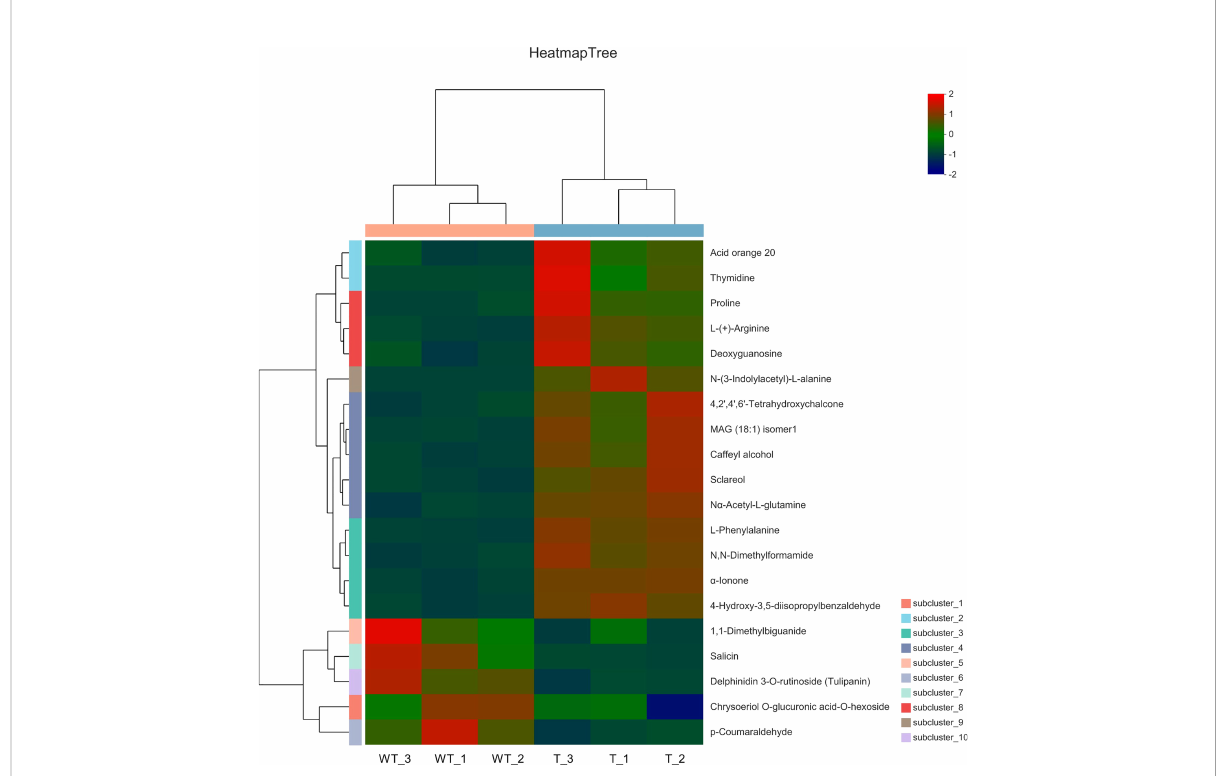
FIGURE 7 Heatmap of metabolic differences of the top 20 substances between wild-type and transgenic rapeseed plants. Note: Metabolites with fold change ≥ 2 or fold change ≤ 0.5 have signi fi cant